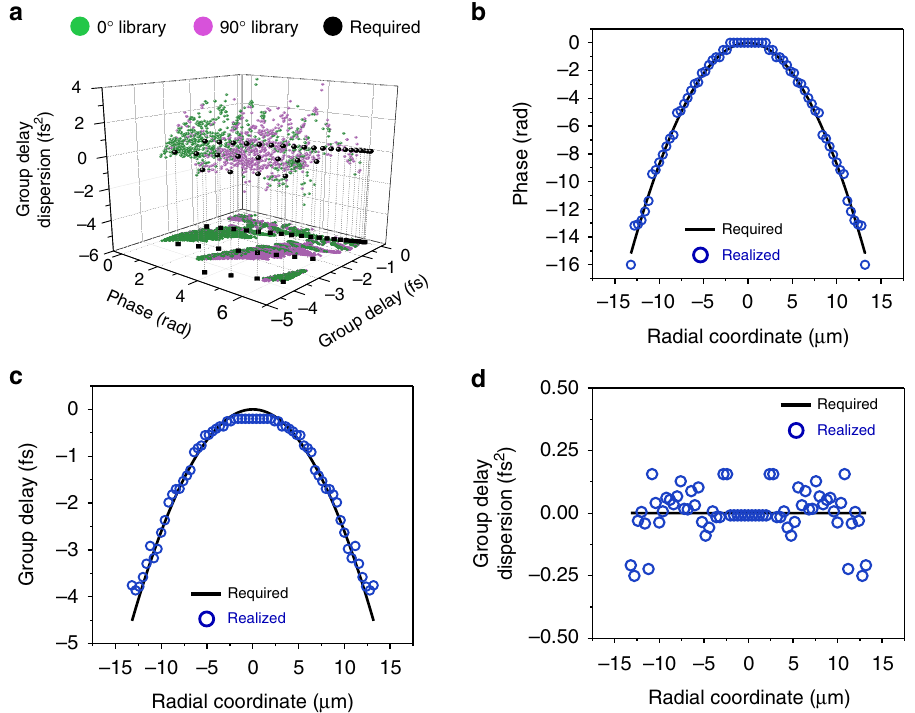
Fig. 2 Required and realized phase and dispersion values for the metalens shown in Fig. 1a. a Phase, group delay, and group delay dispersion for all elements in our simulation library (colored points) and required values (black points). Each element (inset in Fig. 1a) is represented by a green and purple point in the plot because a 90-degree rotation can impart a phase change of π without changing its group delay and group delay dispersion. b – d Realized (blue circles) and required (black curves) phase, group delay, and group delay dispersion at each radial coordinate across the polarization-insensitive and